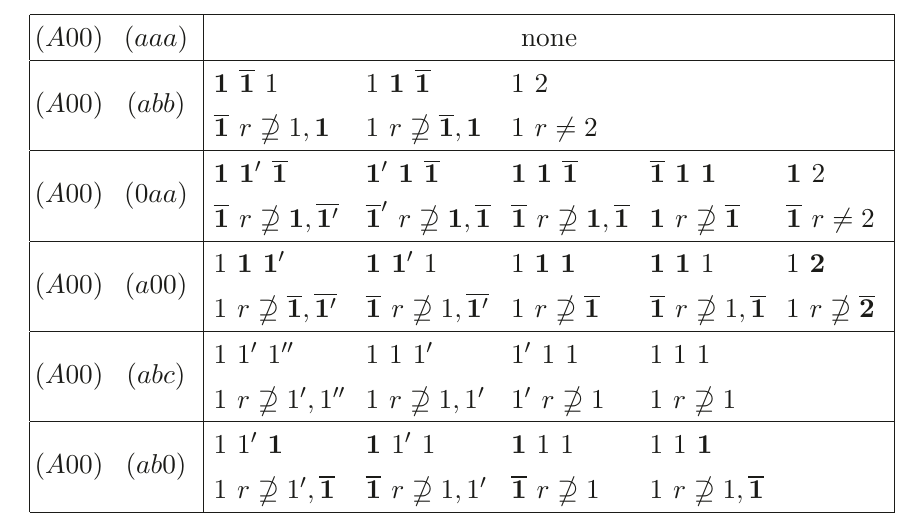
Table 2 . Possible decompositions of U l (above) and U e c (below) into irreducible components (part I). Each line corresponds to a combination of the charged lepton and neutrino mass patterns in the first two columns of table 1. Only the charged lepton pattern ( A 00), which does not require hierarchies among non-zero entries, is considered here. Irreps are denoted by their dimensions. Boldface fonts denote complex or pseudoreal (if 2-dimensional) representations, regular fonts denote real representations. Primes are used to distinguish inequivalent representations, and in the case of complex representations 1 ′ is supposed to be different from both 1 and 1 . “ r ” denotes a generic, possibly reducible representation, different from or not including the specified irreps, as